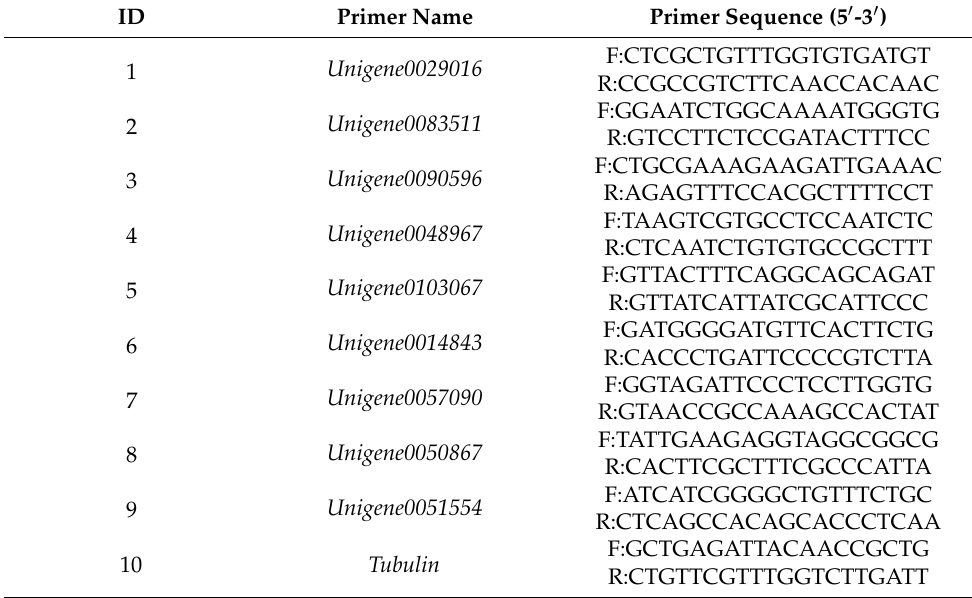
Table 1. The sequences of specific